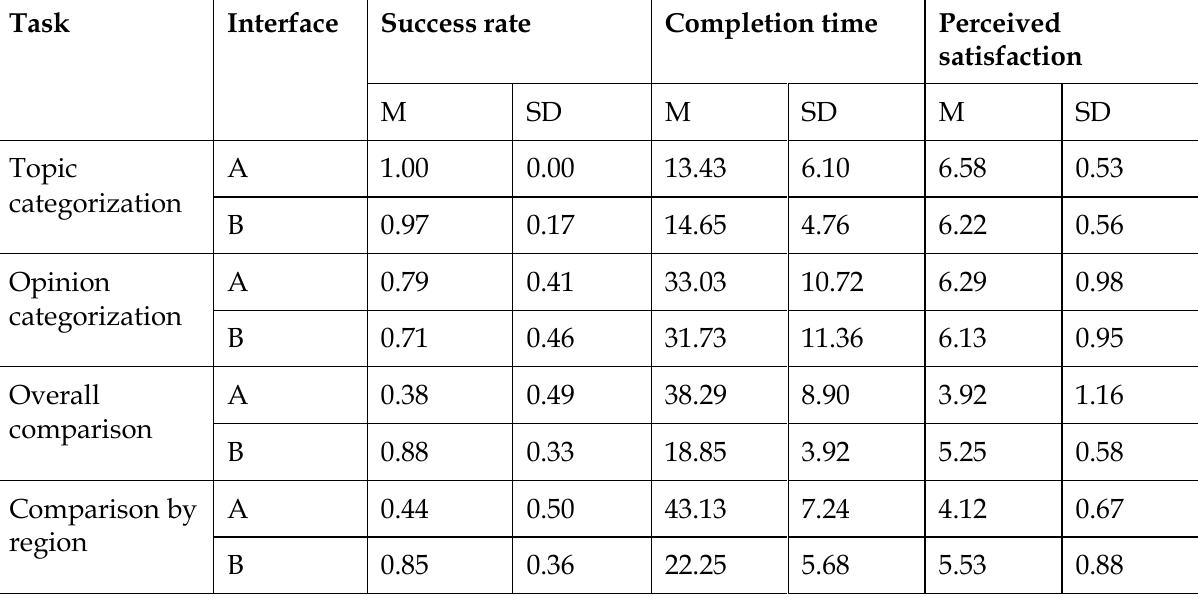
Apendix D Table D1: Means (M) and standard deviation (SD) of success rate, completion time and perceived satisfaction by task type and interface type; A:treemap, B: stacked bac hart (N =